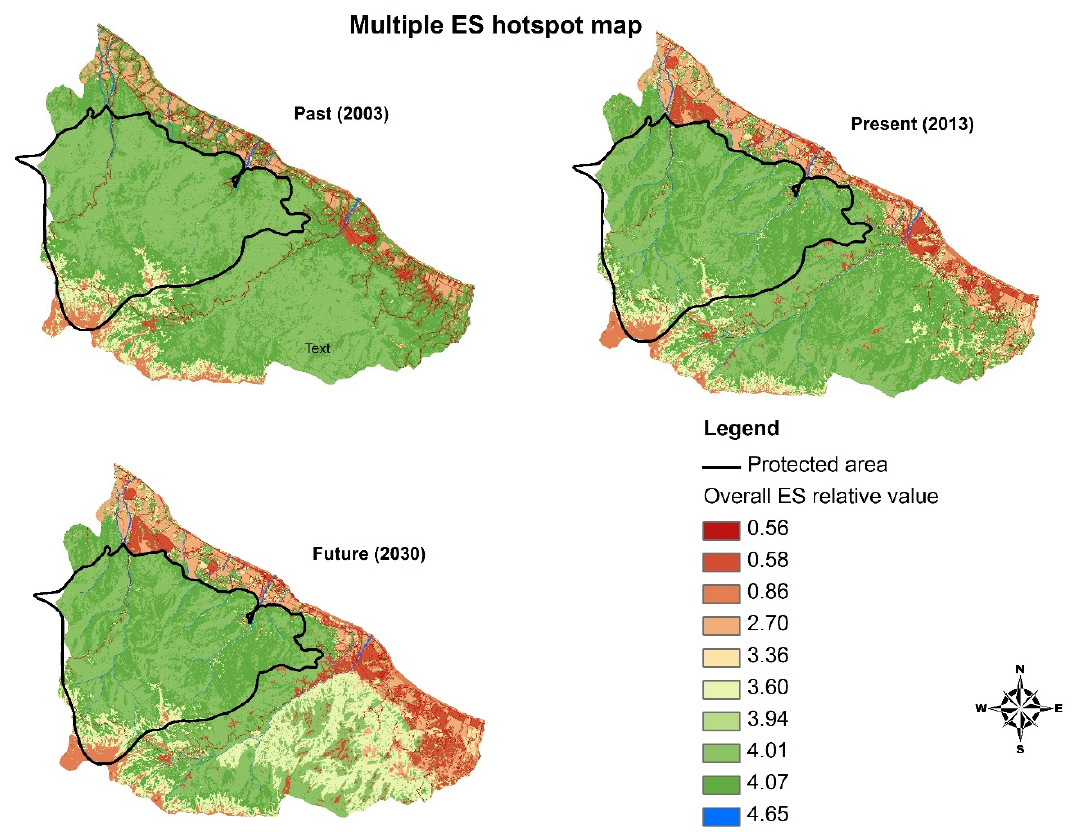
Figure 6. Maps of past, present, and plausible future supply of ES based on multiple service values associated with LULC types and land transformation. Services values are averaged based an integration of all eight individual key ES relative values.